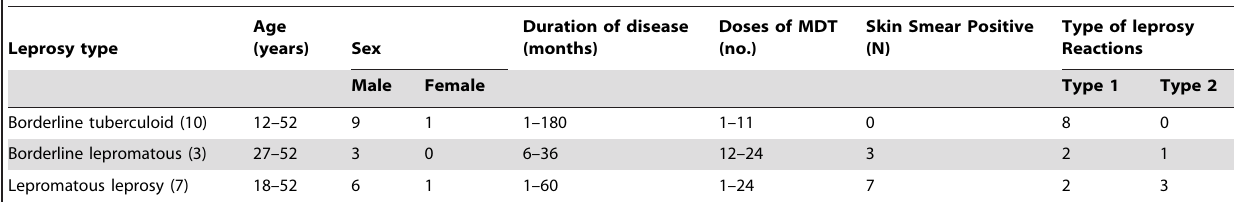
Lepromatous leprosy (7)